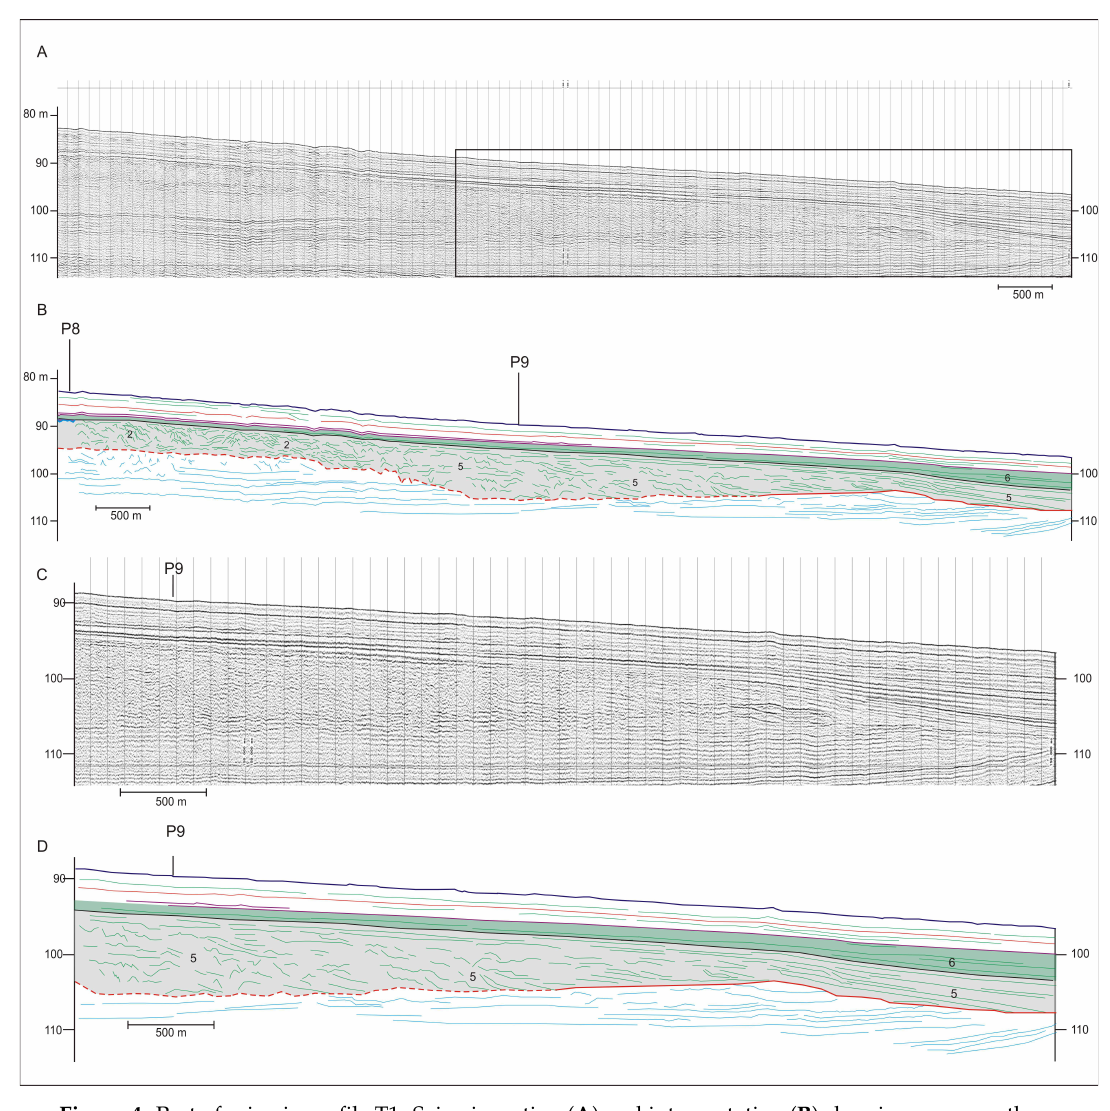
Figure 4. Part of seismic profile T1. Seismic section ( A ) and interpretation ( B ) showing, among others, unit BU2 l, which occupies the deepest parts of the study area. ( C , D ) report an enlargement and its interpretation of the seismic profile sector included in the rectangle reported in ( A ). This unit seems compatible with the Manfredonia Incised Valley (MIV) depositional lobe, which we reinterpreted as a result of MIV and Ofanto deposition and thus renamed to the MIV and Ofanto depositional lobe (MOL): note the low-amplitude, gentle seaward-downlapping reflectors topped by subhorizontal